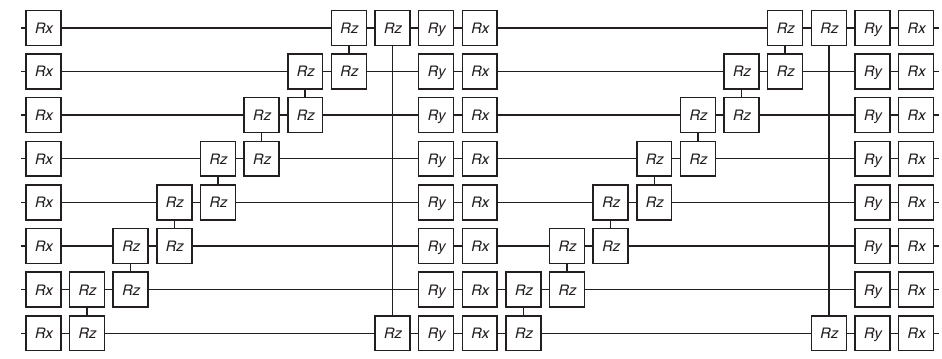
FIG. 11. Example of a 2-block Ansatz circuit of 8 qubits. We used a 10-block circuit of 12 qubits in our simulations in Fig. 2 consisting of overall 372 noisy gates. Each 2-qubit gate undergoes 2-qubit depolarizing noise with 0.5% probability and each single-qubit gate undergoes depolarizing noise with 0.05% probability.